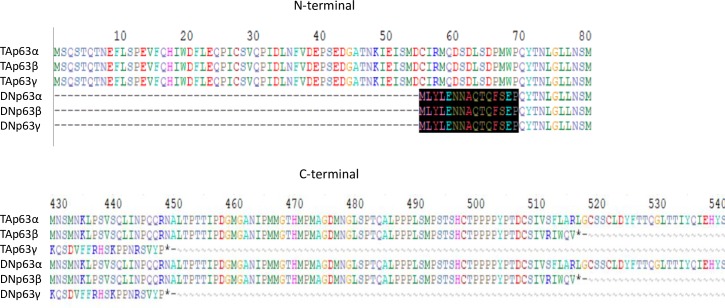
Amino acid alignment of TA and DNp63.Shaded area at N-terminal shows amino acids in DNp63 that differ from those in TAp63. C-terminal alignment reveals the differential lengths and amino acids among 3 different isoforms of p63.